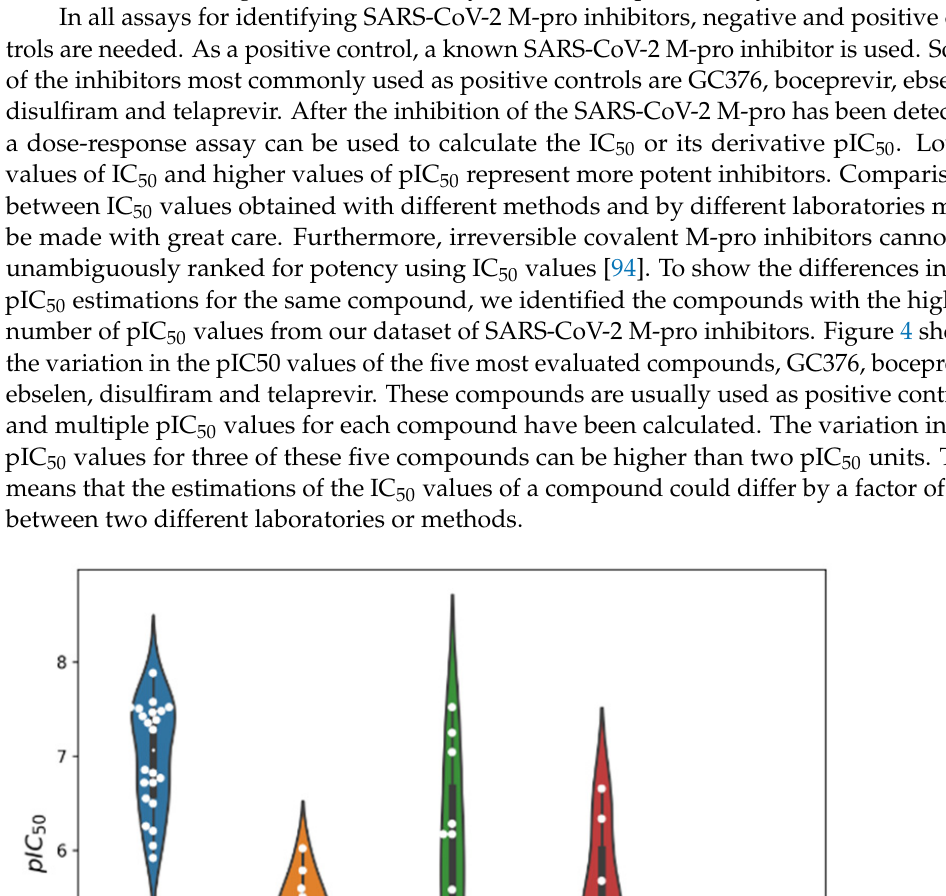
values calculated by different laboratories. The pIC val- 50 50